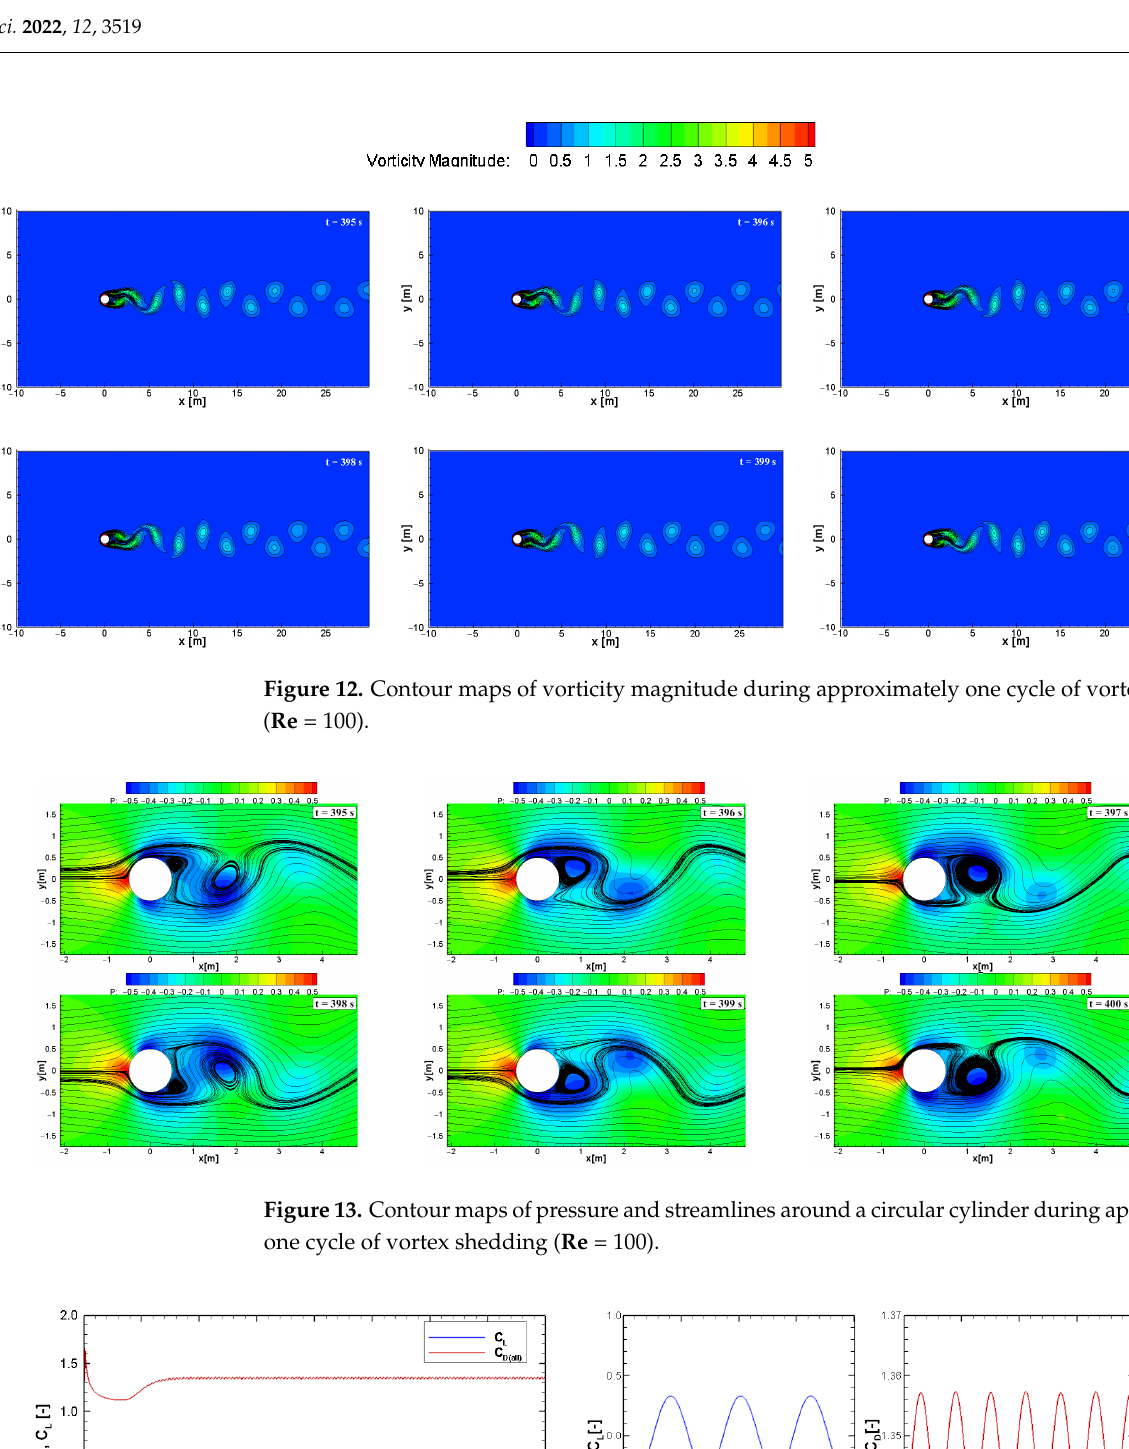
Figure 12. Contour maps of vorticity magnitude during approximately one cycle of vortex shedding ( Re = 100).